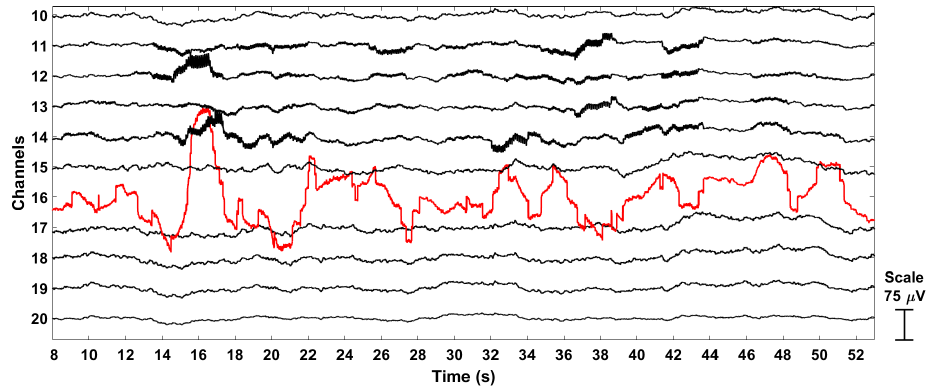
Figure 3. A sample portion of the simulated EEG. Bad channel 16 (in red) is contaminated with aperiodic, step-like artifacts. The channels in black are good